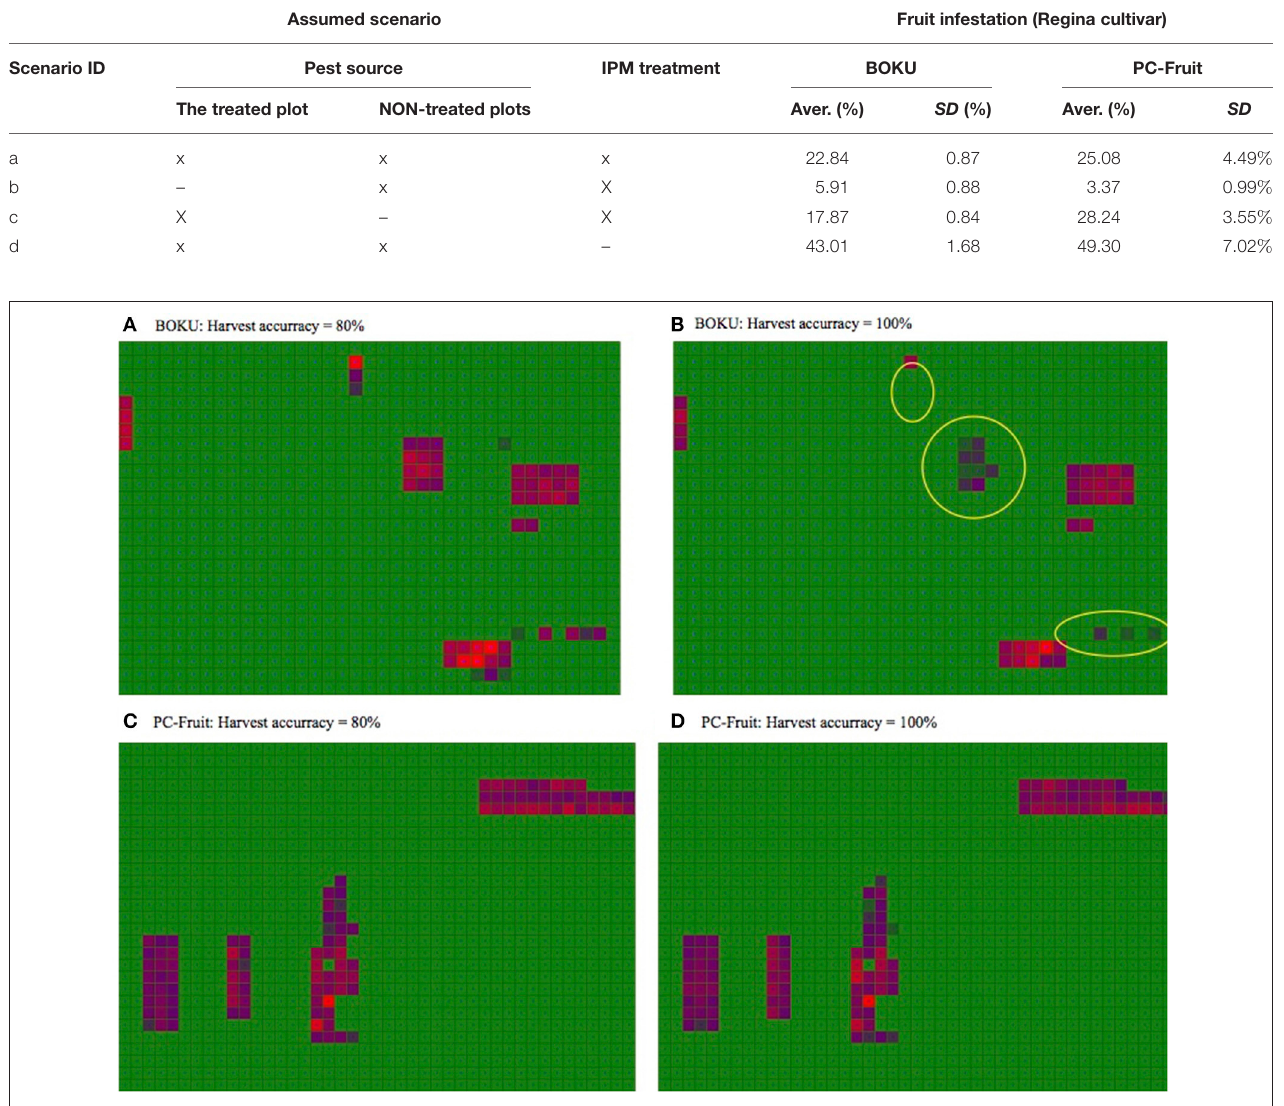
FIGURE 7 | Impact of harvest accuracy on the carry-over of pest population and anticipated emergence next spring. On the diagrams, intensity of the red hue corresponds to the local density of overwintering